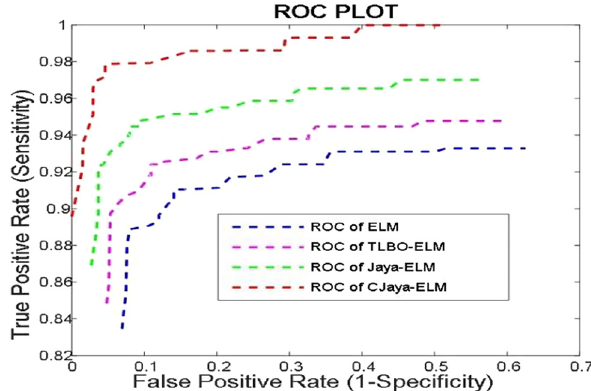
Figure 23: ROC of ELM, TLBO_ELM, Jaya_ELM and CJaya- ELM.